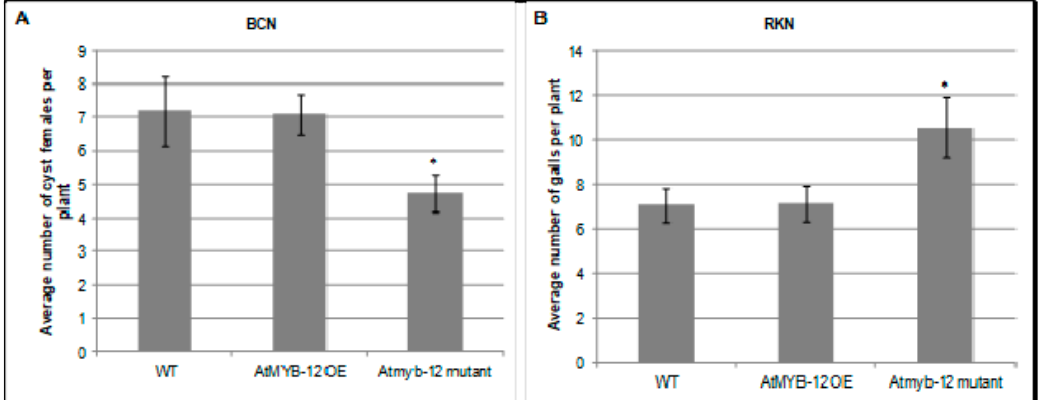
Figure 2. Role of AtMYB12 in H. schachtii ( A ) and M. incognita ( B ) infection. Homozygous lines overexpressing AtMYB12 , Atmyb12 knock-out, and wild-type Col-0 (WT) plants were planted on modified Knop’s medium and 10 days-old seedlings were inoculated with approximately 60 surface sterilized J2 of either H. schachtii or M. incognita . Three weeks after inoculation, the number of cyst female nematodes (for suagr beet cyst nematode) per root system or galls (for southern root-knot nematode) were counted. Data are presented as means ± standard errors. Mean values significantly different from wild type (Col 0) as determined by t test ( p < 0.05) are denoted by asterisks. Similar results were obtained from a second, independent biological replicate.